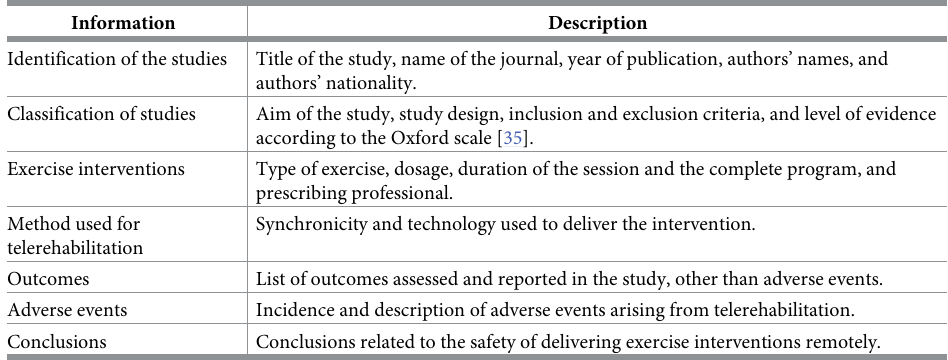
Table 2. Information to be extracted from the included